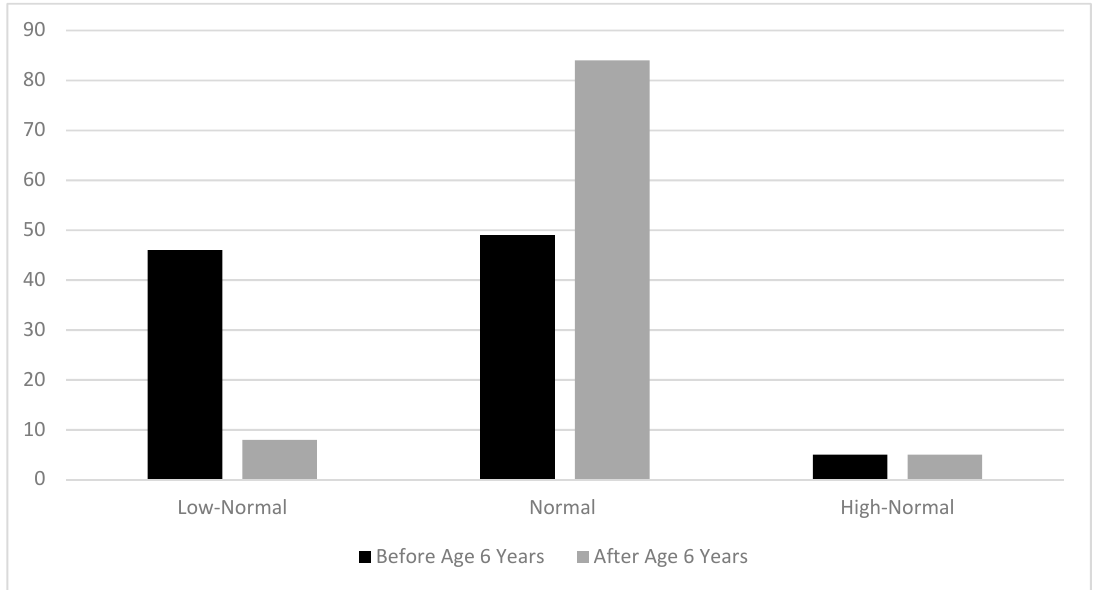
Figure 3. Goals for plasma lysine concentrations in patients with GA-1 before and after age 6 years (% of survey responses for each category).